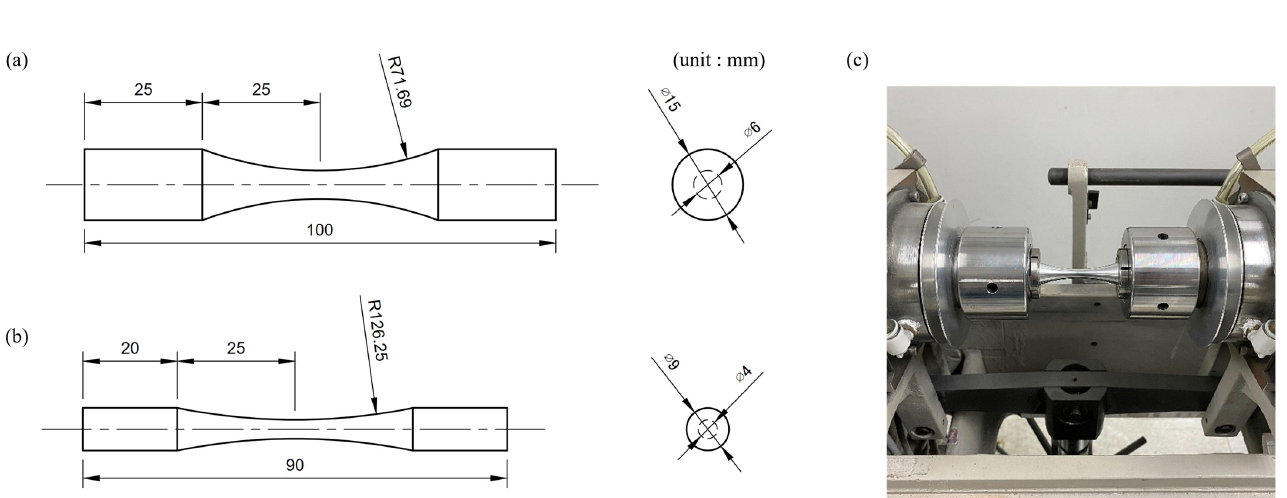
Figure 1. Schematics of rotary bending specimens : ( a ) Al-NF, ( b ) Al-F. ( c ) Specimen mounted on the rotary bending test machine, Model H-7 test machine from Shimadzu (Kyoto,